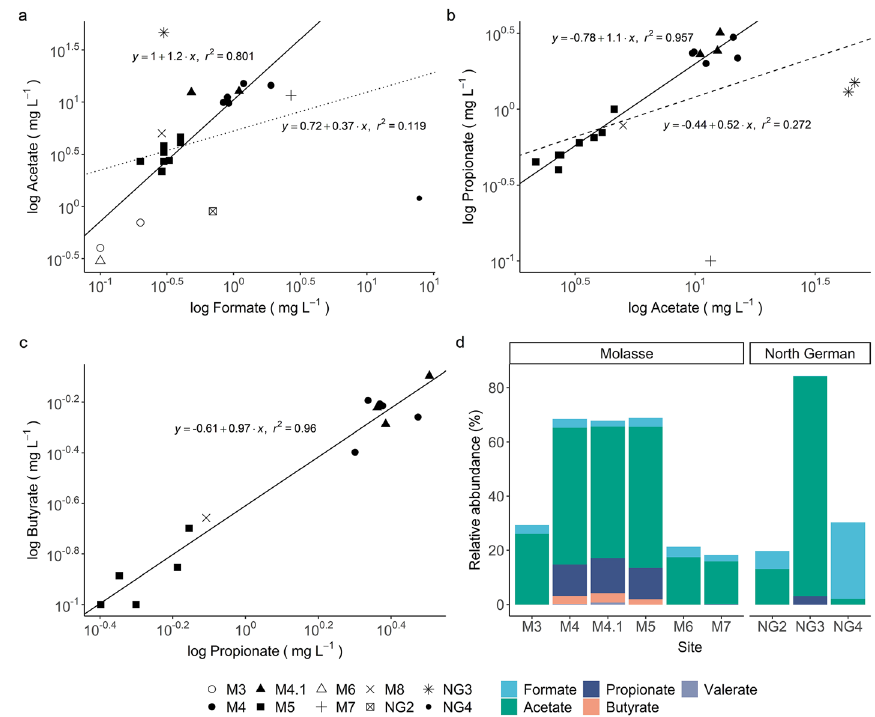
Fig. 13 Logarithmic plots of a) formate and acetate (dotted and solid line represent a regression with all data and only Molasse Basin data, respectively). b) Acetate and propionate (dashed and solid line represents a regression with all data and without NG3 and M7, respectively). c) Propionate and butyrate concentrations from the Molasse and North German Basin. d) Mean relative abundance of organic acid anions with regard to the DOC concentrations in the fluid